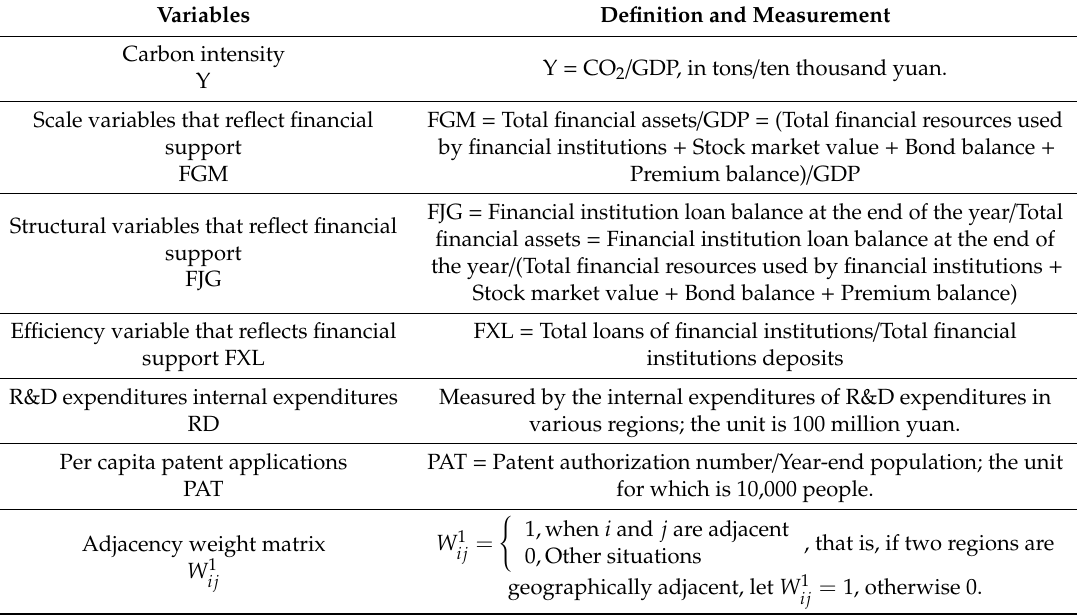
Table 1. Definition and measurement of